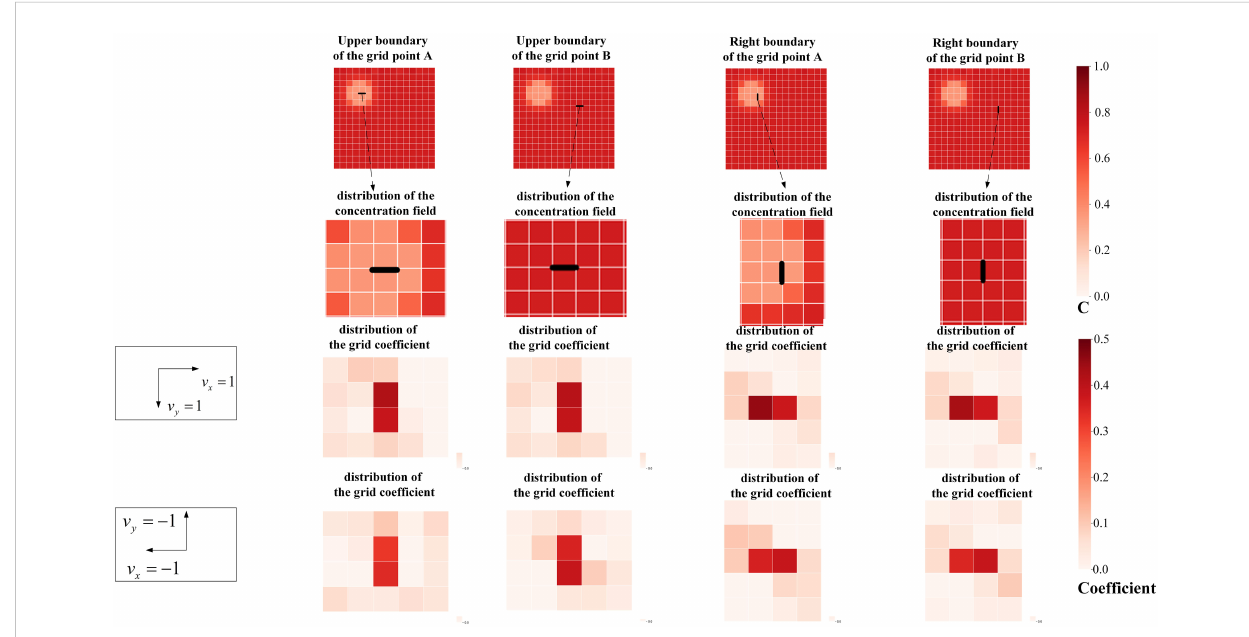
FIGURE 11 The comparison of prediction results of models using different temporal layers as features. The fi rst line selects two spatial points with signi fi cant differences in surrounding concentrations from the spatial fi eld and extracts the upper and right boundaries of the two points. The second row is the spatial discretization coef fi cient predicted by each boundary. The third row is a heat map made according to the different position coef fi cients in the coef fi cient template when the horizontal velocity fi eld is +1, and the vertical velocity fi eld is +1. The third row is a heat map made according to the different position coef fi cients in the coef fi cient template when the horizontal velocity fi eld is -1, and the vertical velocity fi eld is